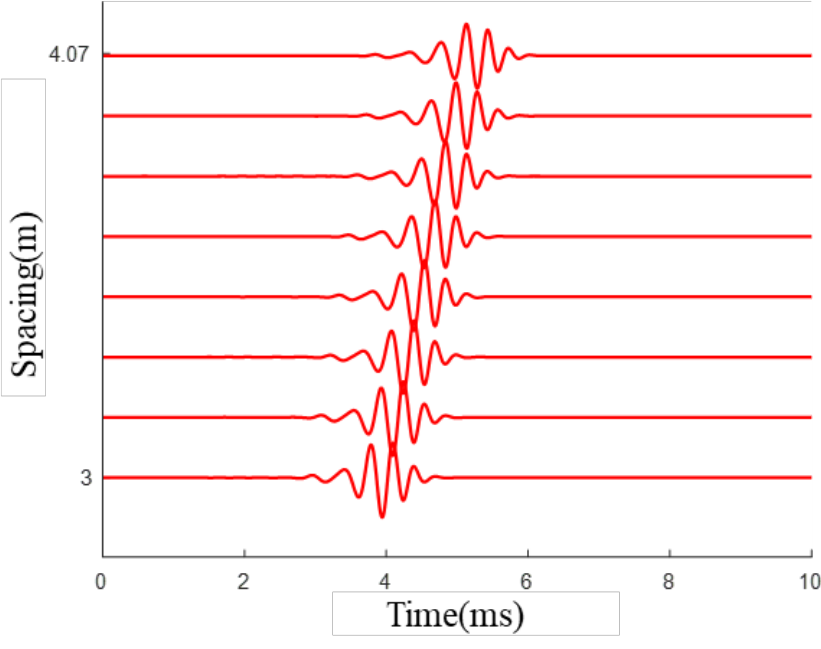
Figure 2. Waveforms of the numerical simulation model.